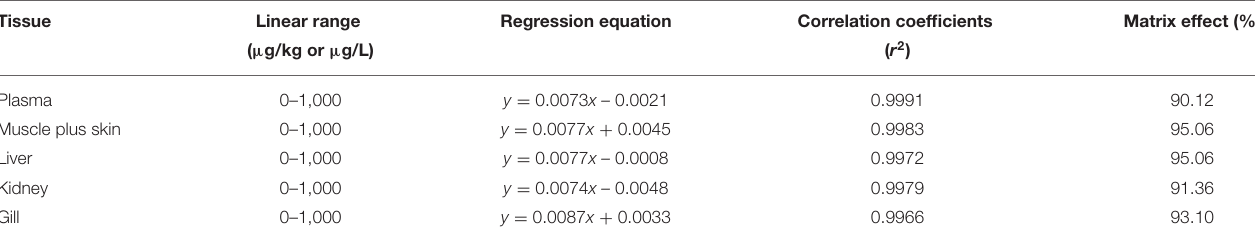
TABLE 2 | The linear range, regression equations, correlation coefficients ( r 2 ) and matrix effects of tiamulin in matrix-matched calibration curves. Tissue Linear range Regression equation